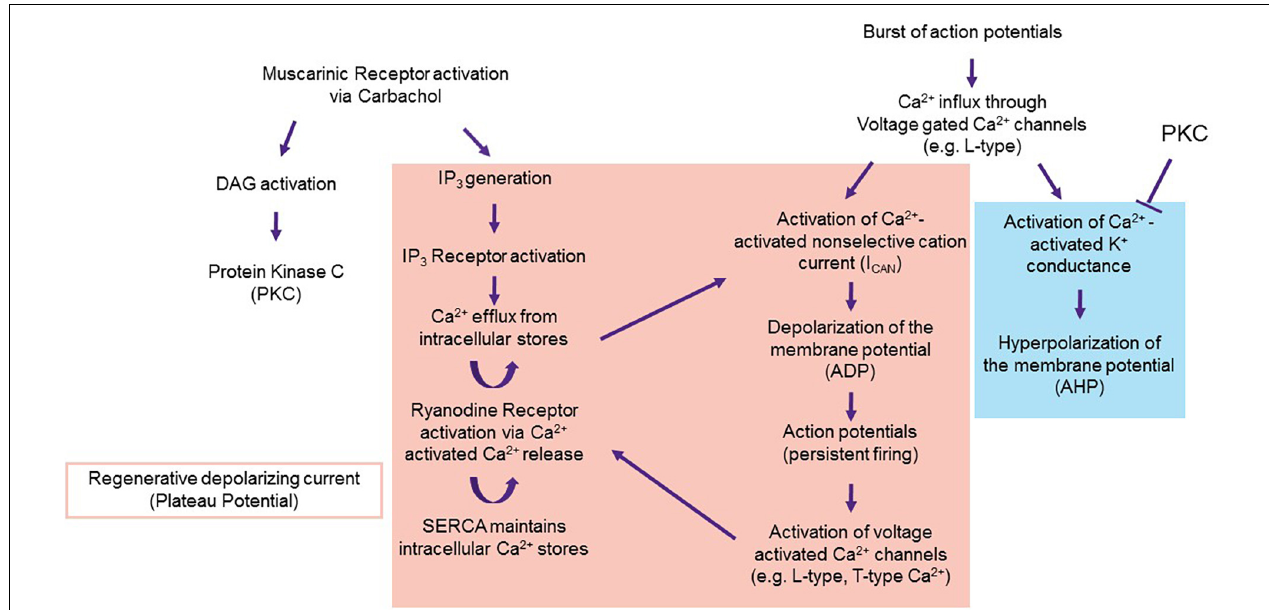
FIGURE 8 | Proposal of the mechanism underlying the ADP. Persistent firing in LEC III starts with muscarinic activation via carbachol. Carbachol activates the M1 and M3 pathways, which result in the activation of PKC and IP 3 . PKC inhibits Ca 2 + activated K+ conductance, disallowing for the generation of the postburst AHP (blue) and unmasking the ADP and the plateau potential (red). Proteins that underlie the ADP and plateau potential may include TRPC (for ADP generation), and voltage gated Ca 2 + channels and internal calcium stores (for the regenerative plateau potential). From Lin et al.